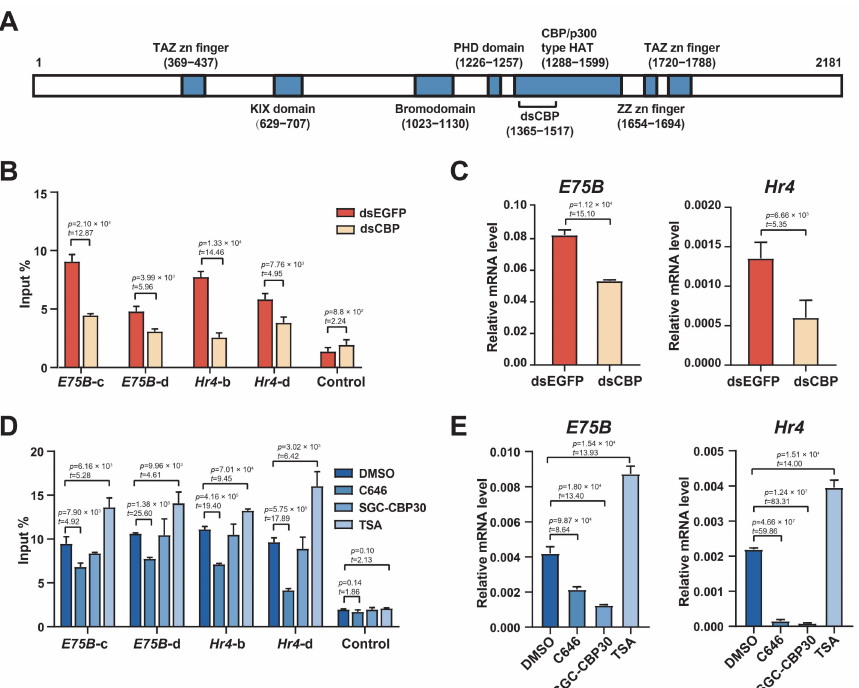
Figure 5. CBP HAT activity was critical for ecdysone-responsive gene expression. ( A ) Scheme of CBP organization, indicating the main functional motifs and the sites targeted by the dsRNA. Length is proportional to the lengths of amino acids. ( B ) ChIP-qPCR of H3K27 acetylation in BmE cells treated with dsRNA against EGFP or CBP. DNA was quantified using primers designed to amplify the enhancer regions of E75B and Hr4 gene loci, as shown in Figure 1C,E. Error bars: standard error of the mean (SEM) from three biological replicates measured in duplicate. Student’s t -test (df = 4). ( C ) RT–qPCR analysis of E75B and Hr4 expression in BmE cells treated with dsRNA against EGFP or CBP. Ratios of RNA levels of the gene of interest to RP49 RNA levels were calculated. Error bars: standard error of the mean (SEM) from three biological replicates measured in duplicate. Student’s t -test (df = 4). ( D ) ChIP-qPCR of H3K27 acetylation in BmE cells treated with DMSO, C646 (a CBP HAT domain-specific inhibitor), SGC-CBP30 (a CBP-bromodomain-specific inhibitor), or trichostatin A (TSA, a HDAC inhibitor), respectively. The DNA was quantified using primers designed to amplify the enhancer regions of E75B and Hr4 gene loci, as shown in Figure 1C,E. Error bars: standard error of the mean (SEM) from three biological replicates measured in duplicate. Student’s t -test (df = 4). ( E ) RT-qPCR of E75B and Hr4 expression in BmE cells treated with DMSO, C646, SGC-CBP30, and TSA, respectively. We calculated the ratios of the RNA levels of the gene of interest to those of RP49 . Error bars: standard error of the mean (SEM) from three biological replicates measured in duplicate. Student’s t -test (df =